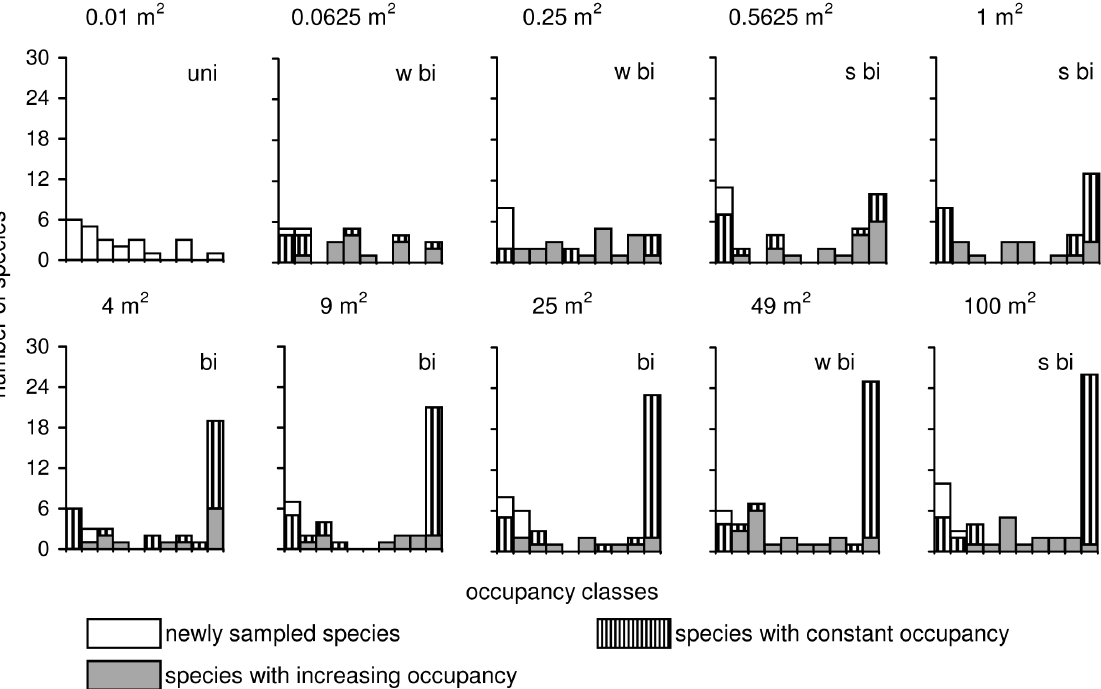
Figure 1. Case 1. Increasing size of sample unit (quadrat size). Shifting of species between occupancy classes as a function of increasing quadrat size in a meadow dominated by Bromus erectus . Species presences were sampled in ten regularly spaced sets of nested quadrats including ten quadrat sizes. Determination of the shape of the occupancy distributions and the significance of modes were calculated using the test procedure of Tokeshi (1992): bi = bimodal, s bi = strongly bimodal, w bi = weakly bimodal, uni = unimodal. ‘Newly sampled species’ were recorded for the first time in the corresponding quadrat size, ‘species with constant occupancy’ belonged to the same occupancy class in the next smaller quadrat size, and ‘species with increasing occupancy’ belonged to a lower occupancy class in the next smaller quadrat